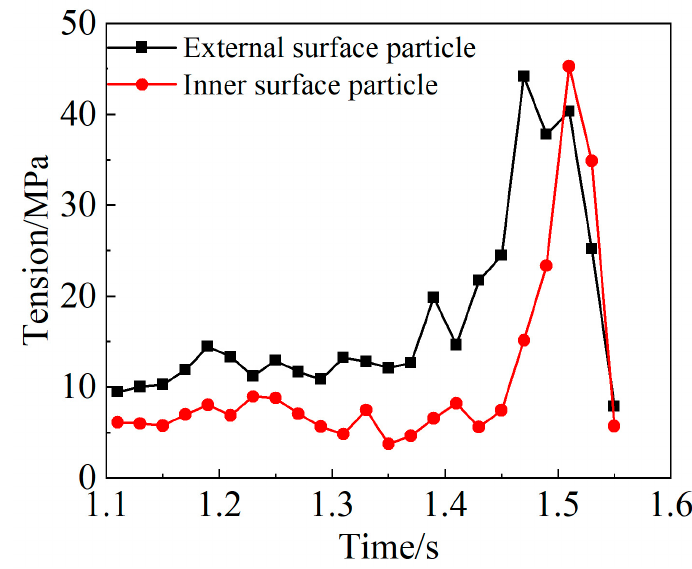
Figure 8. Tension variations in the TSR process.